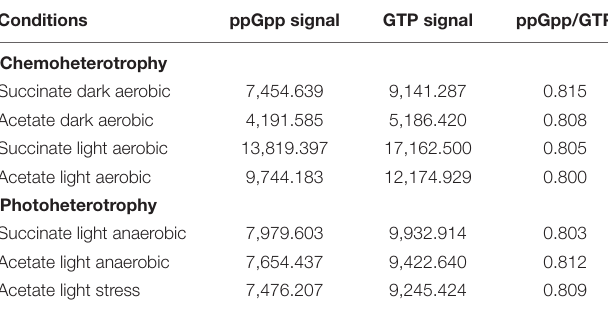
TABLE 1 | Signal left by ppGpp and GTP molecules following autoradiography of polyethyleneimine (PEI) thin-layer chromatography of formic acid cell extract from Rhodospirillum rubrum computed by ImageJ